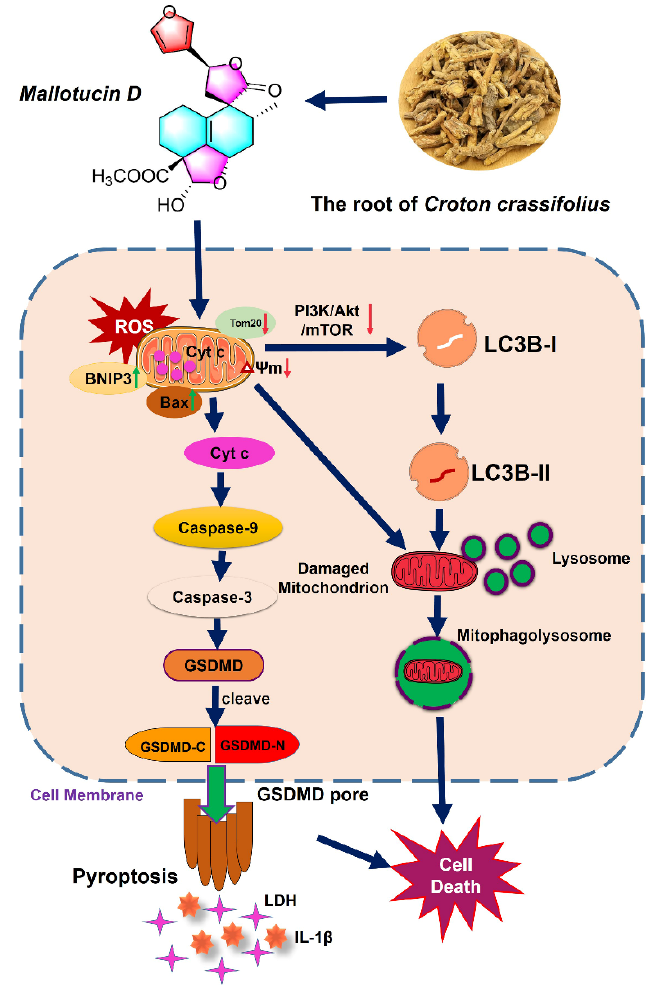
Figure 8. Model of the antitumor mechanism of MLD in HepG2 cells. MLD firstly caused mitochondrial damage and decreased the mitochondrial membrane potential, resulting in the production of ROS. The overproduction of ROS then increased BNIP3, inducing PI3K/AKT/MTOR-related mitophagy and GSDMD-related pyroptosis, leading to the induction of HepG2 cell death in vitro and in vivo.